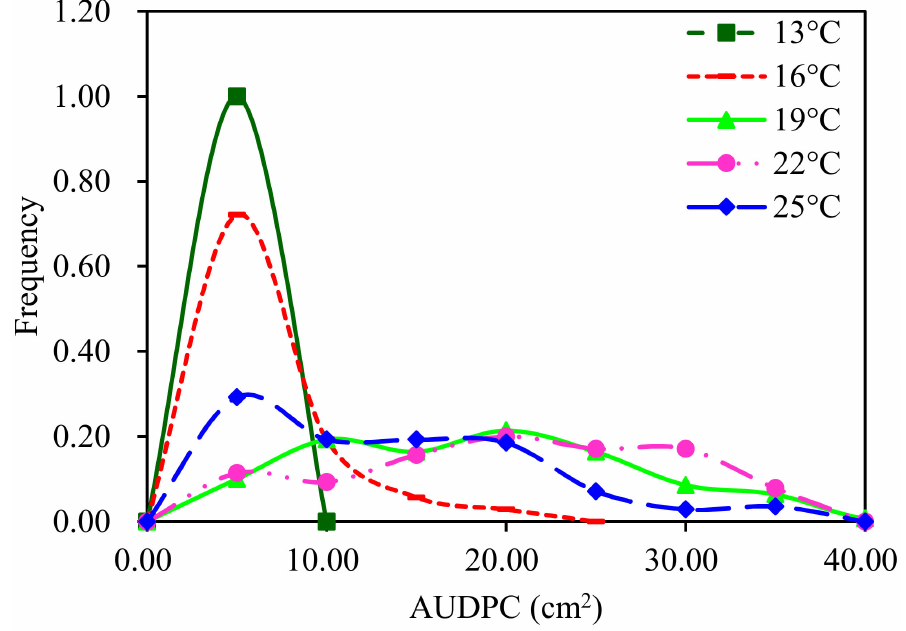
Figure 1. Frequency distribution of aggressiveness in the 140 Phytophthora infestans isolates sampled from seven geographic locations with different annual mean temperatures in China. The aggres- siveness, represented by AUDPC, was estimated from the lesion sizes of 140 Phytophthora infestans isolates at 2–6 days